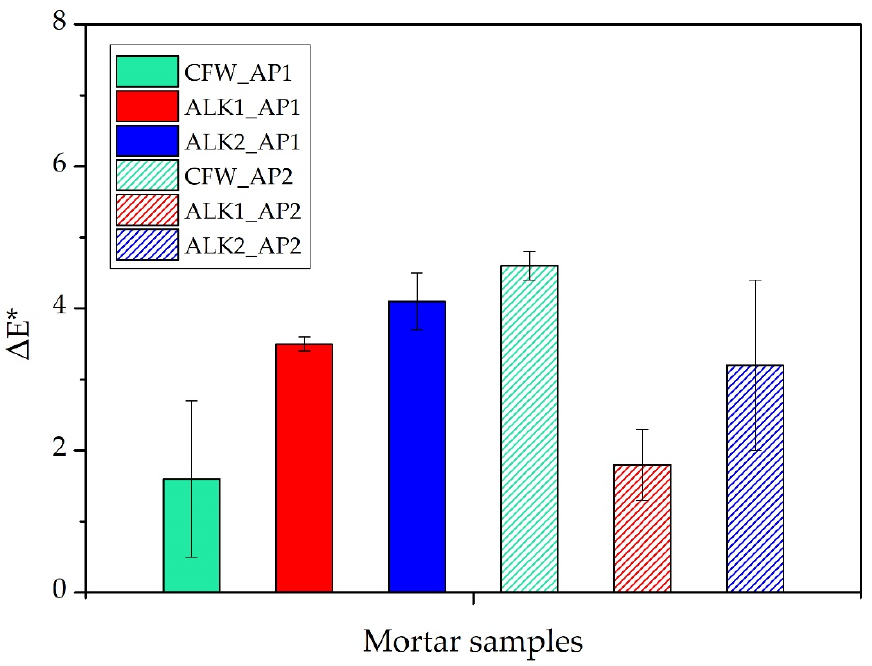
Figure 6. Chromatic variation after the application of all products with both procedures. CFW: Ca(OAcAc) 2 ; ALK1: Ca(OTHF) 2 in ethanol; ALK2: Ca(OTHF) 2 in 2-butanol; AP1: brush till refuse; AP2: absorption through capillarity .